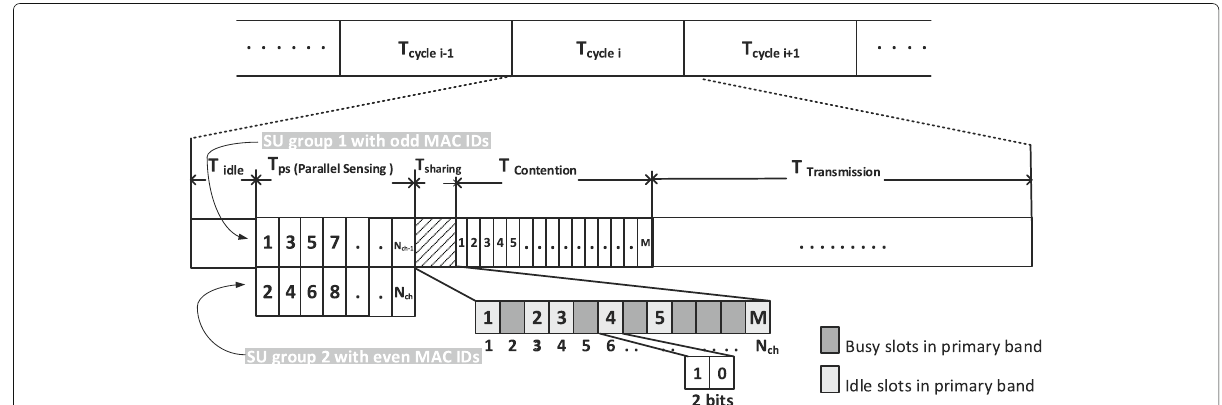
Fig. 3 Simple frame structure of proposed parallel sensing scheme protocol, showing only two user